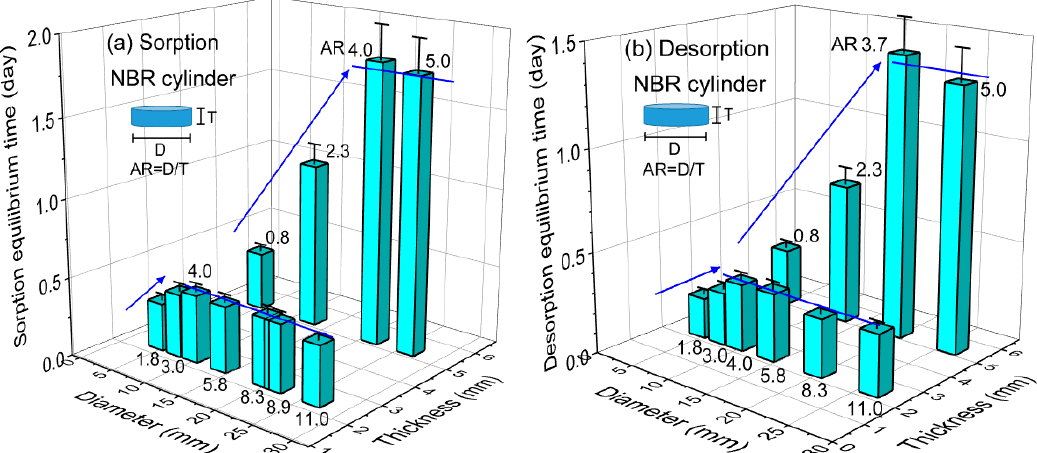
Figure 7. Three-dimensional plot of ( a ) sorption and ( b ) desorption equilibrium time versus volume for NBR. The number at the top of the bar indicates the aspect ratio (AR = D/T) of the cylindrical rubber. D and T indicate the diameter and thickness, respectively, of the cylindrical-shaped specimen. The blue slanted lines with arrows indicate the linear increase in equilibrium time versus thickness. The blue horizontal lines indicate constant equilibrium time versus diameter.